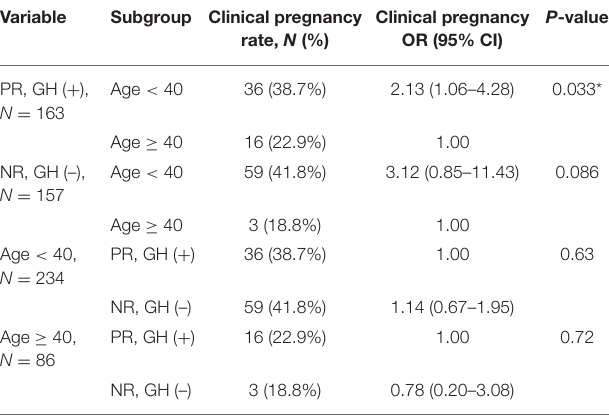
TABLE 6 | Subgroup analysis of the pregnancy outcome for poor-responder (PR) with GH co-treatment and normal-responder (NR) without GH co-treatment